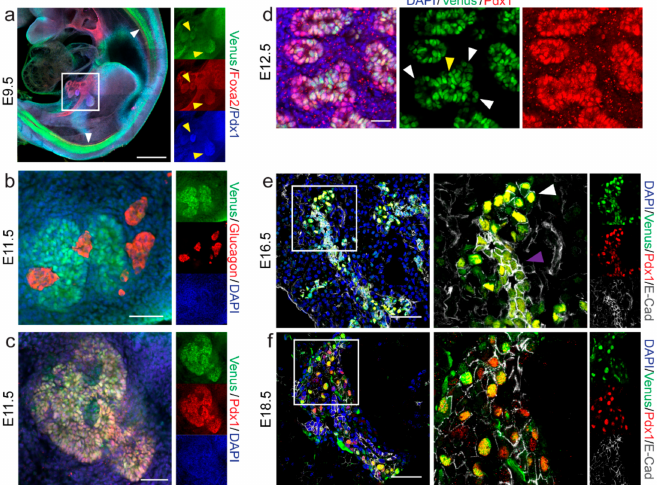
Figure 2. Nkx6-1-VF expression during embryonic pancreas development. ( a ) Whole embryo immunostaining using iDISCO protocol of E9.5 presenting Nkx6-1-VF expression in notochord (white arrows) and pancreatic buds marked by high expression of Pdx1 and Foxa2 (yellow arrows). Tile scan; size bar 500 µ m. ( b , c ) Whole pancreas immunostaining at stage E11.5 shows ( c ) colocalization of Nkx6-1-VF and Pdx1 in the pancreatic epithelial but ( b ) is absent in the glucagon-secreting cells. Scale bar 50 µ m. ( d – f ) Pancreas section immunostaining of E12.5, E16.5 and E18.5 analyzing the expression of Nkx6-1-VF during embryonic pancreas development. The expression of the fusion protein through primary and secondary transition follows a similar pattern to Pdx1. ( d ) At E12.5, the expression of Nkx6-1-VF is observed in the duct domain (yellow arrow) but not in the tip domain (white arrow). Scale bar 20 µ m. ( e , f ) During endocrine lineage specification, higher expression levels outside the duct marked with high expression of membrane marker E-cadherin is observed.